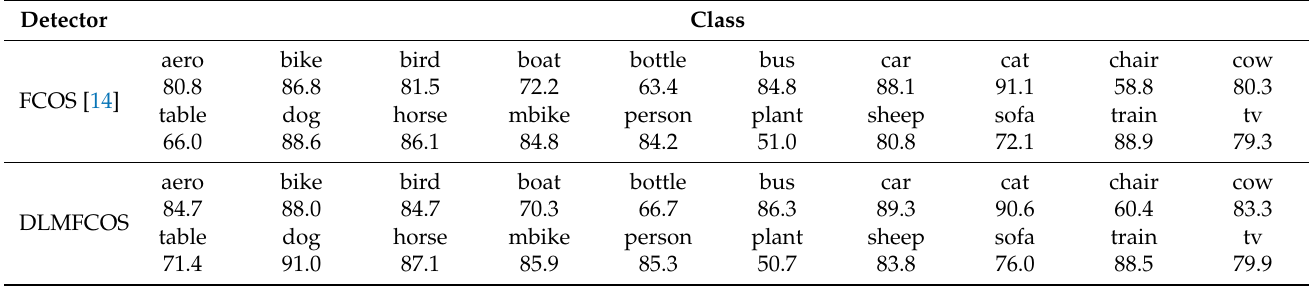
Table 8. The ablation study for DLMFCOS analysis on the PASCAL VOC 2007 test